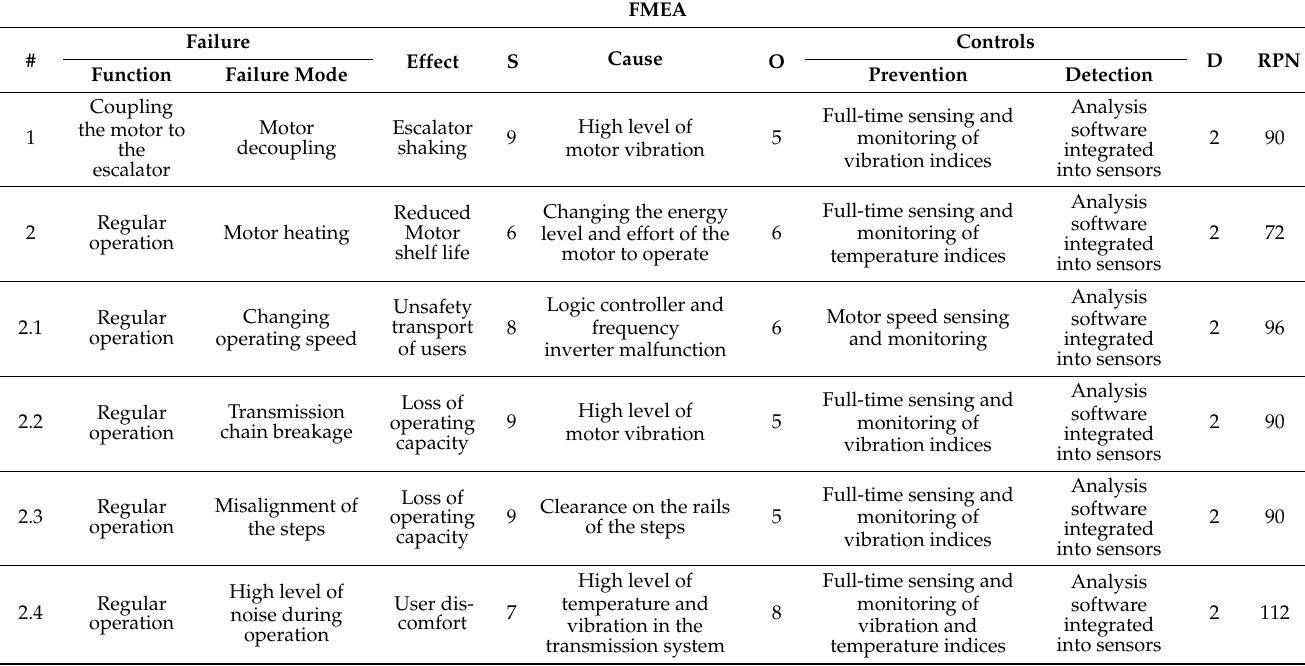
Table 12. FMEA after selected smart sensor